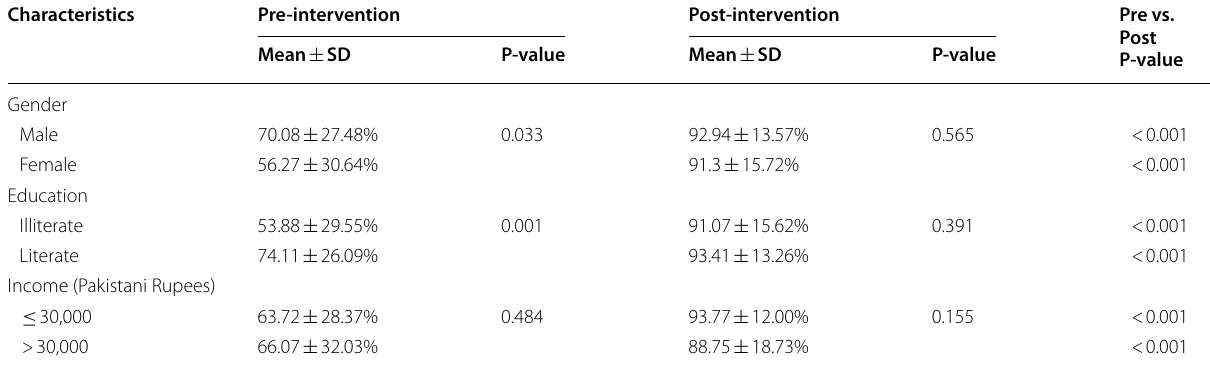
Table 3 Pre- and post-intervention mean correct response rate stratified by gender, literacy and